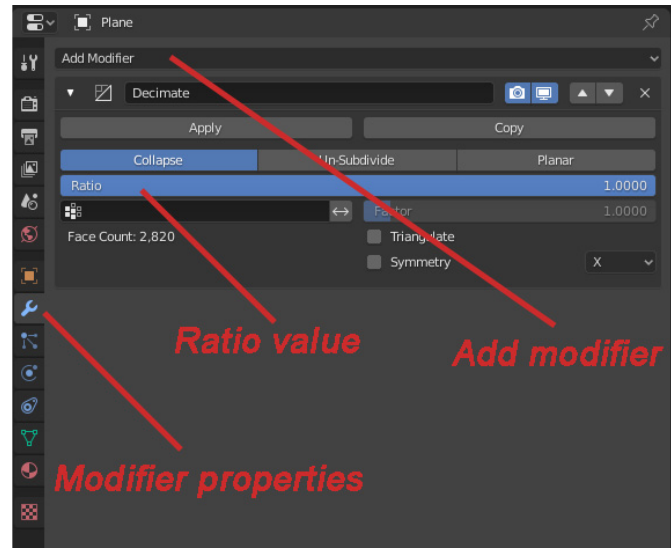
Figure 1. Menu panel on Blender for the decimate modifier.